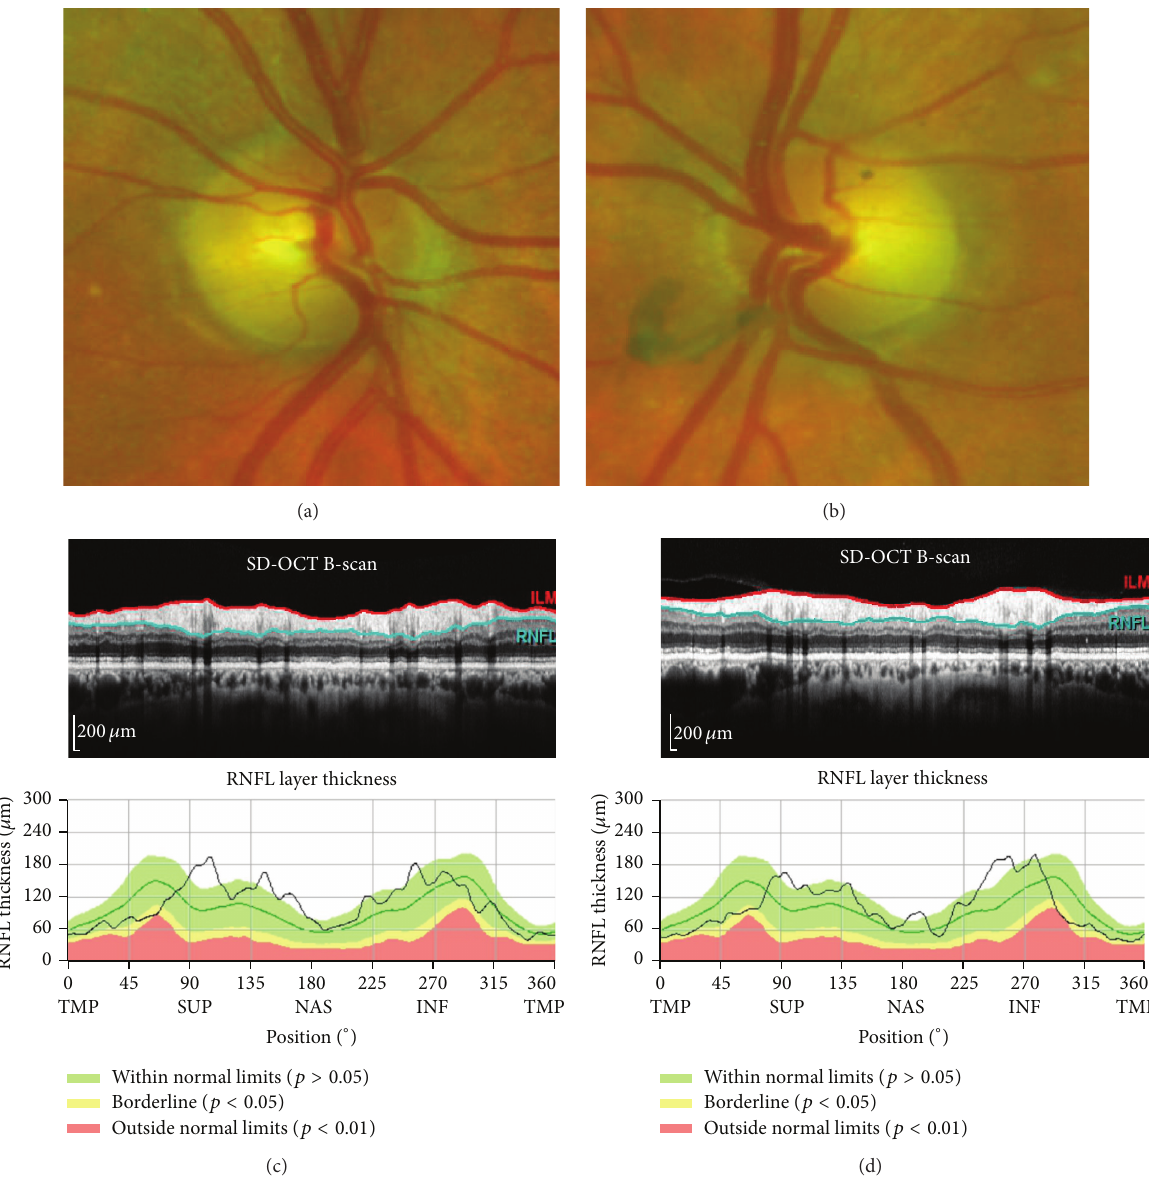
Figure 3: (a, b) Optic nerve head and (c, d) nerve fibre layer thickness imaging showing mild temporal pallor but no glaucomatous disc cupping and normal peripapillary nerve fibre thickness